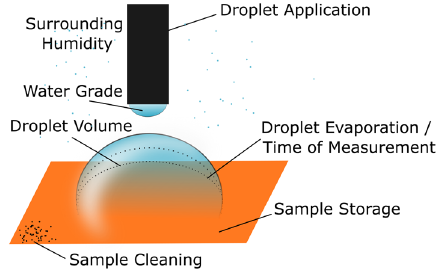
Figure 1. Overview of influences on static contact angle measurements covered in this